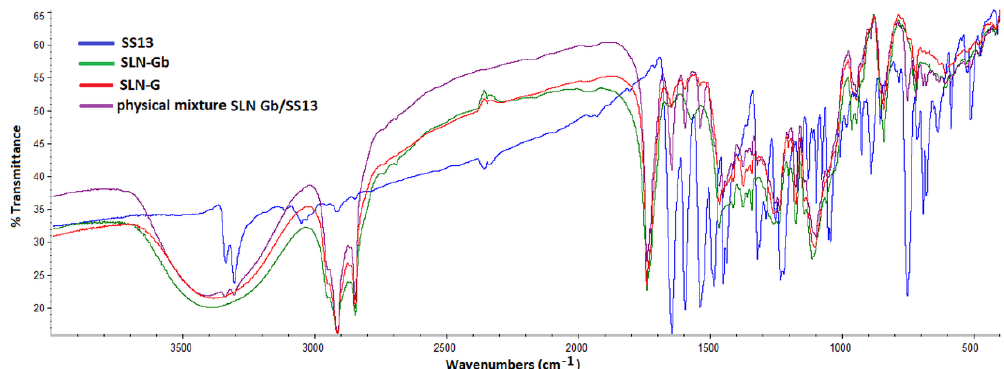
Figure 7. FTIR spectra of SS13, SLN-Gb, SLN-G and physical mixture of SLNGb and SS13.